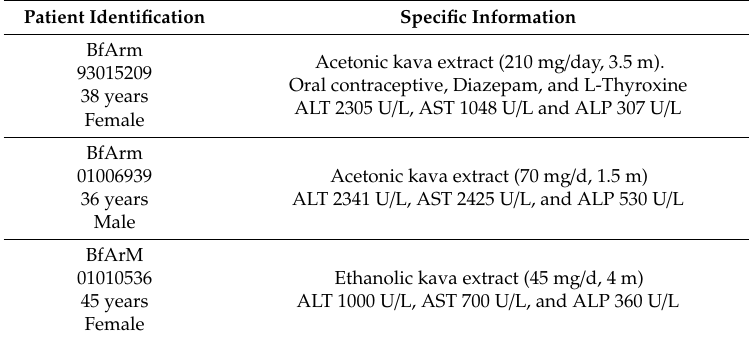
Table 7. Clinical data of cases of causality relationship with kava exposure